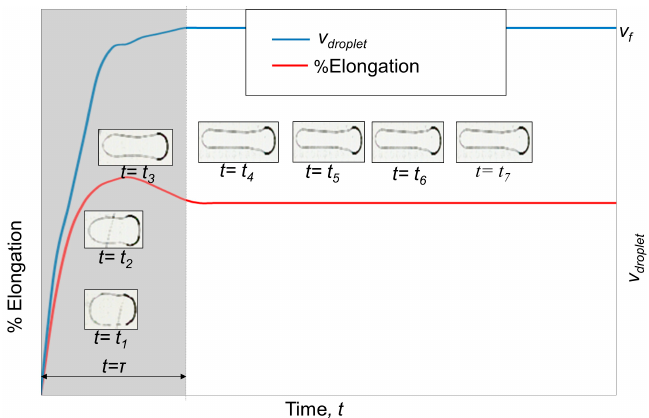
Figure 5. A representative droplet velocity ( v droplet ) profile and % elongation vs. time for slender electrode arrays in S L 2 scheme. The shaded area represents the “transition region” and the remaining area of the plot represents “constant shape region”. The inset photos show the droplet profiles at different instants of those two regimes.